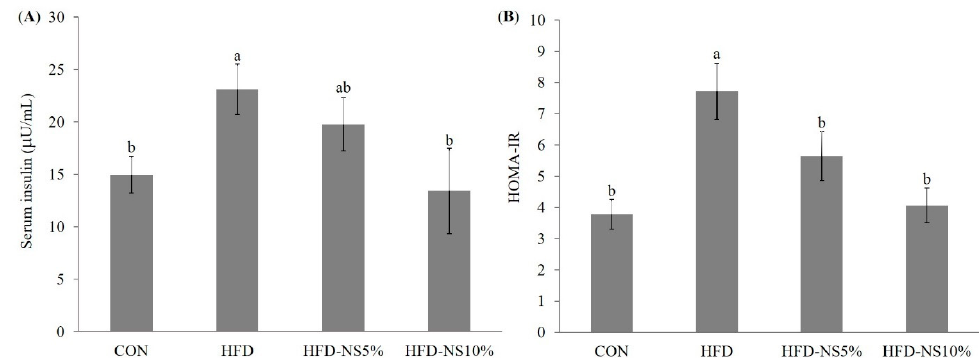
Figure 1. Effects of Nelumbinis Semen powder on insulin resistance in C57BL/6 mice fed a normal diet (CON), high-fat diet (HFD), high-fat diet with 5% Nelumbinis Semen powder (HFD-NS5%), and high-fat diet with 10% Nelumbinis Semen powder (HFD-NS10%). ( A ) Effect of Nelumbinis Semen powder on serum insulin level and ( B ) homeostatic model assessment insulin resistance (HOMA-IR). Values are the mean ± SE ( n = 8/group). a, b The different letters represent significant differences at p < 0.05 by Duncan’s multiple range test.